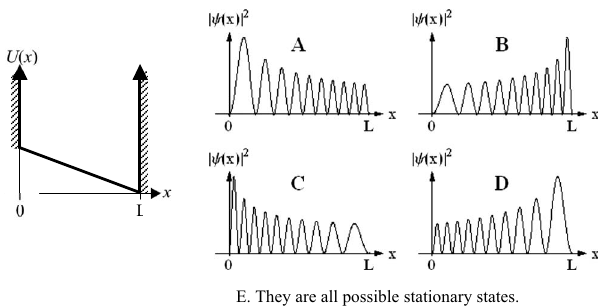
figure on the left below shows a potential energy function U ( x ), where the potential energy is infinite if x is less than 0 or greater than L, and has a slanted bottom in between 0 and L, so that the potential well is deeper on the right than on the left. Which of the plots of | ψ ( x )|² vs. x is most likely to correspond to a stationary state of this potential well?